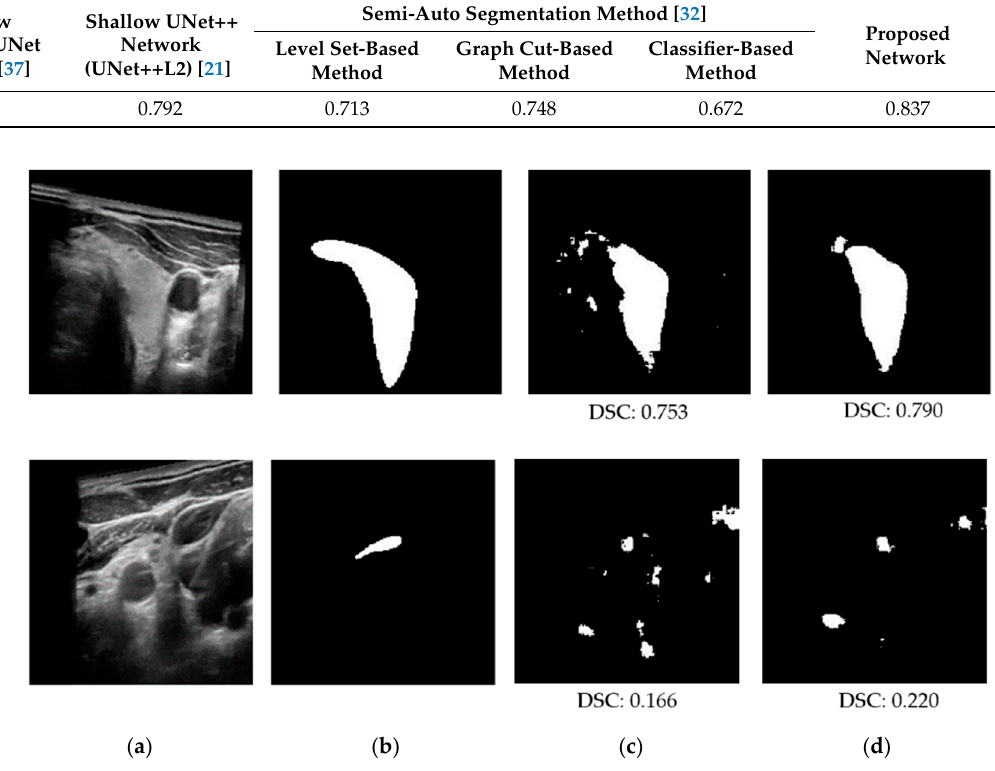
Figure 12. Examples of segmentation result with the 3DThyroid dataset: ( a ) input image; ( b ) label image; ( c ) results obtained by shallow UNet network; ( d ) results obtained by the proposed method. Table 9. Comparison of segmentation performance (DSC) between our proposed method and pre- vious study on 3DThyroid dataset .